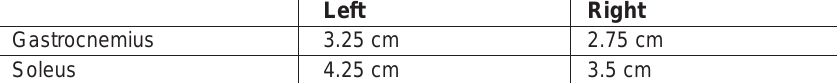
Table 3: Pain-free ROM